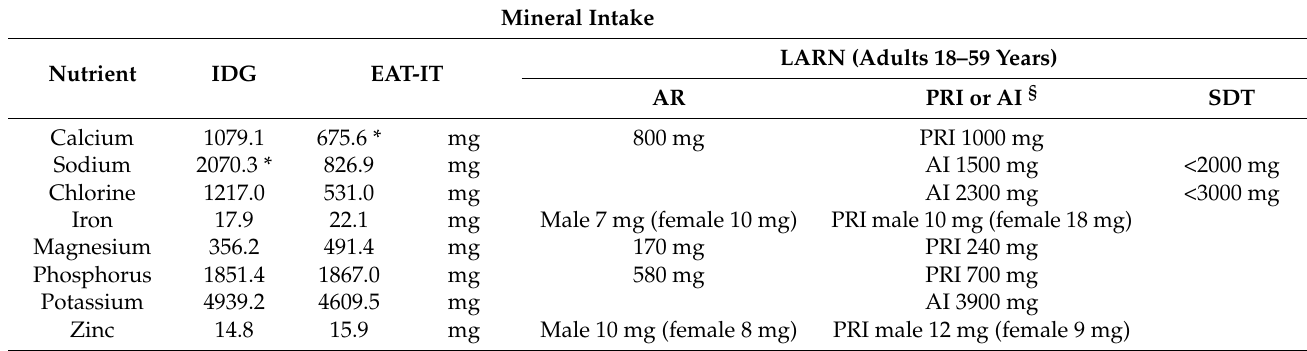
Table 6. Comparison between minerals provided by the IDG and EAT-IT dietary plans for a 2500 kcal diet. Mineral